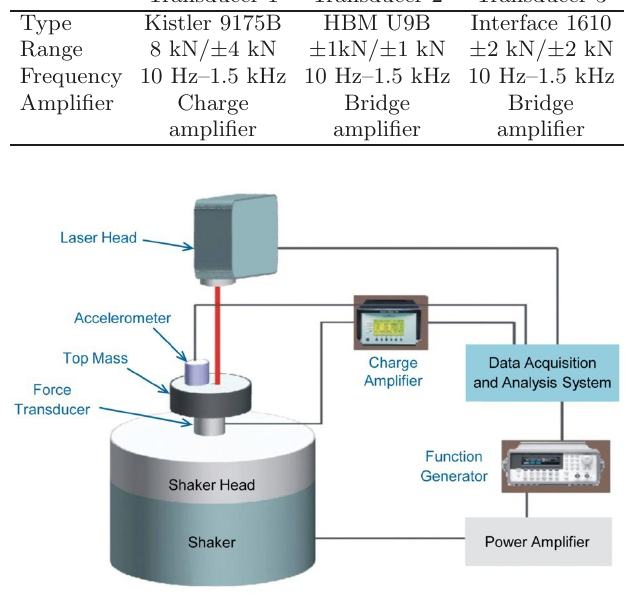
Fig. 2. Schematic of the measurement set-up.